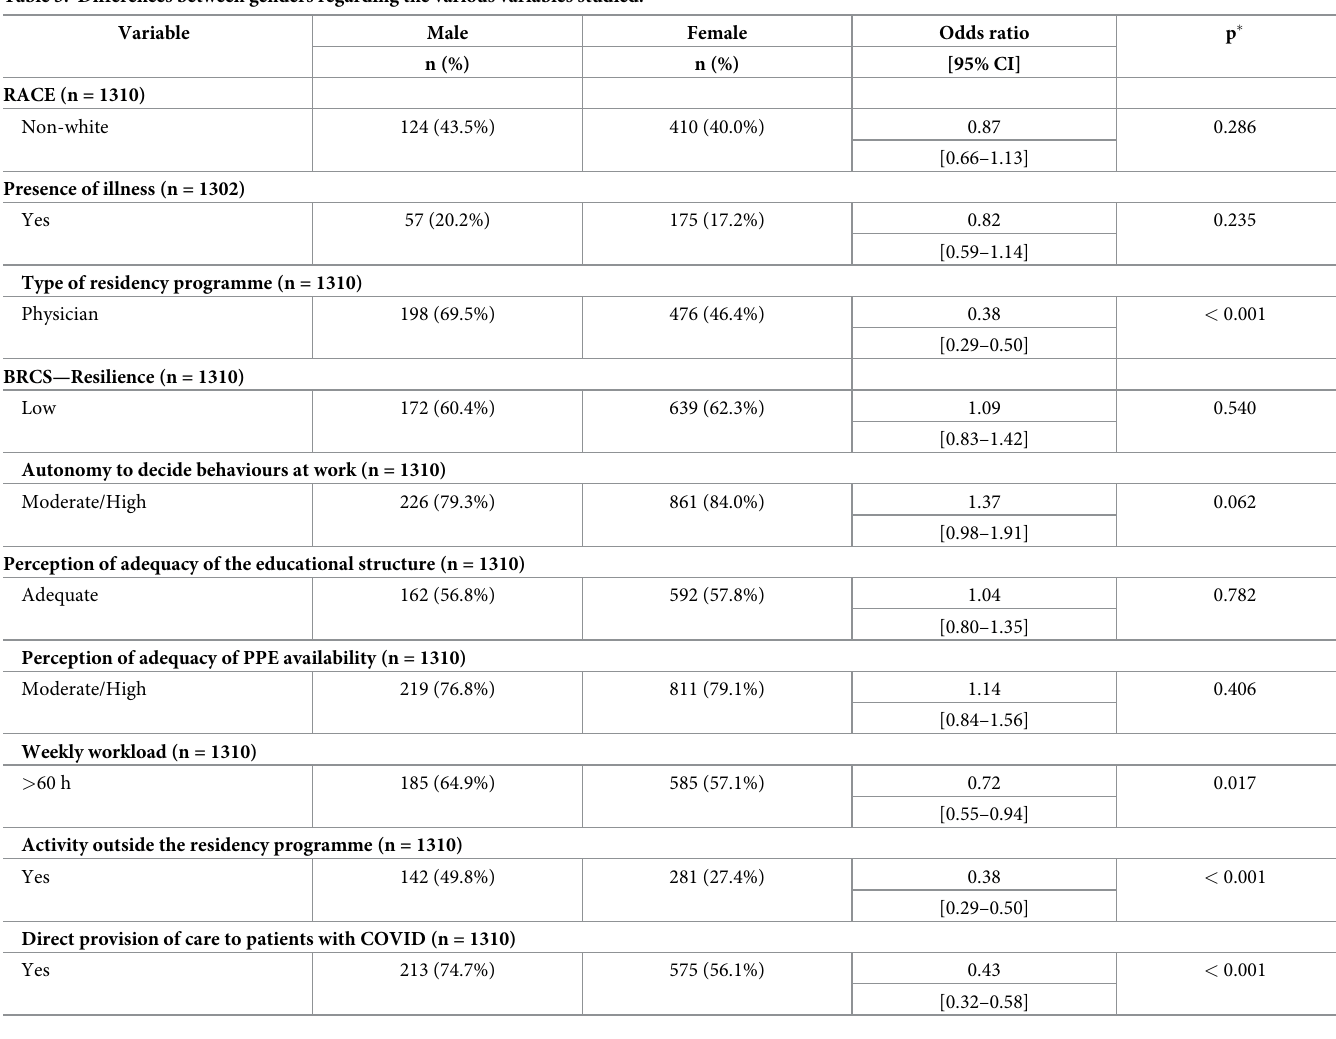
Table 5. Differences between genders regarding the various variables